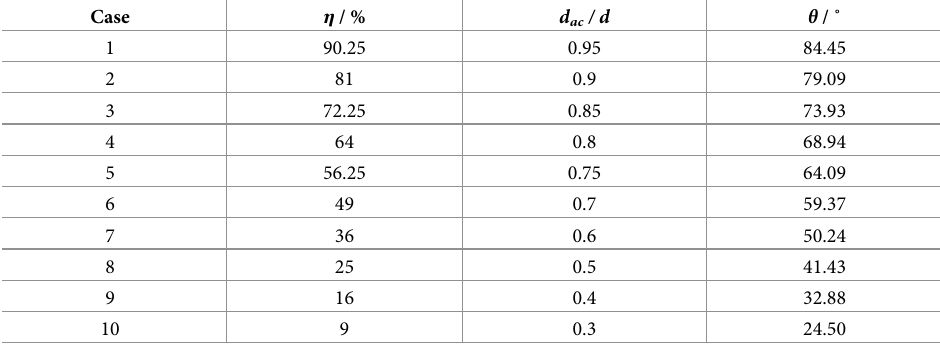
Table 1. Values of parameters used in the numerical simulation and